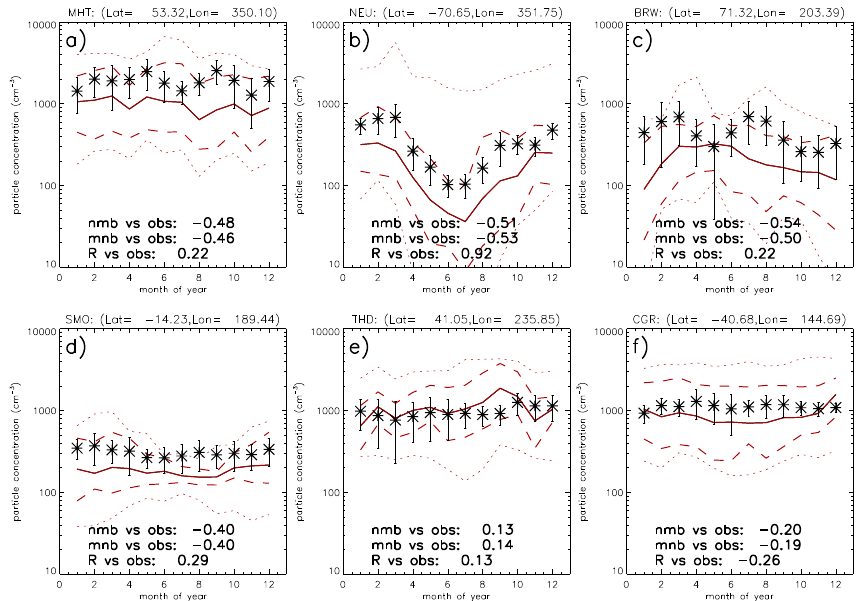
Figure 8. Simulated annual cycle in surface N(D p > 10nm/14nm/3nm) against CPC observations at marine boundary layer GAW sites Mace Head (10nm), Neumayer (14nm), Barrow (14nm), Samoa (14nm), Trinidad Head (14 nm) and Cape Grim (3nm). The solid line is the geometric mean over the central two-thirds of models in each month, with the dashed lines the minimum and maximum over those central-8. The dotted line shows the minimum and maximum over all 12 models. The error bars on the observations indicate the standard deviation over the several years of data shown in Table